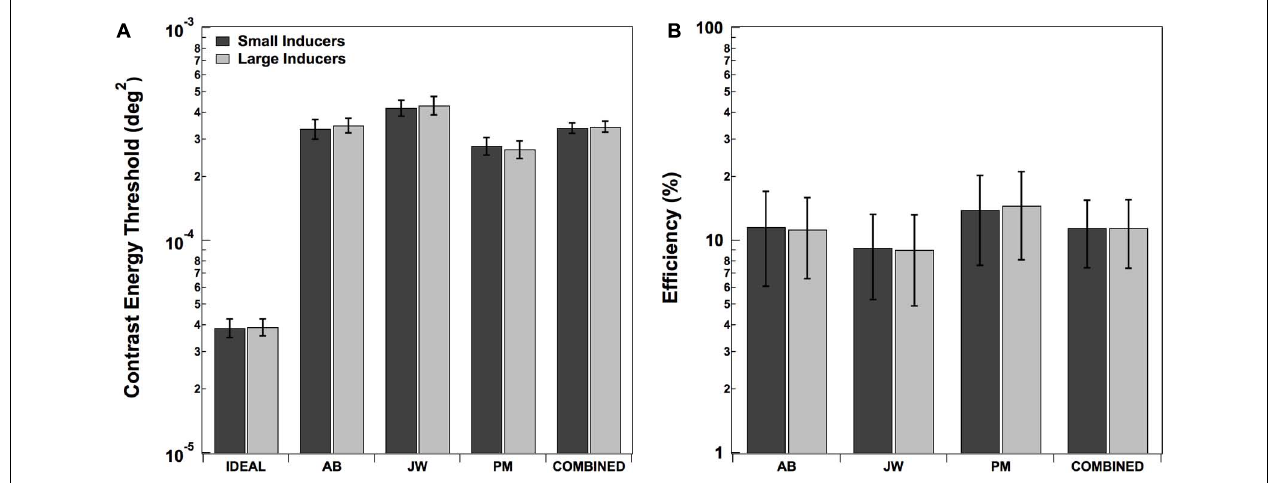
FIGURE 3 | Contrast energy thresholds (A) and efficiencies (B) in each condition of Experiment 2. Error bars for individual observers correspond to ± 2 standard deviations, estimated by bootstrap simulations. Error bars on combined thresholds correspond to ± 2 standard errors of the mean.